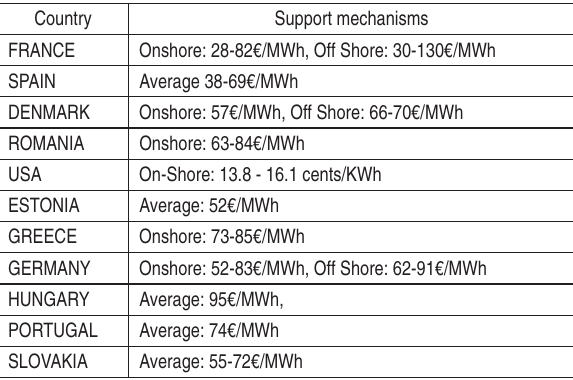
Fig. 2. Market forecast for 2016-2020 Table 1. Public Support